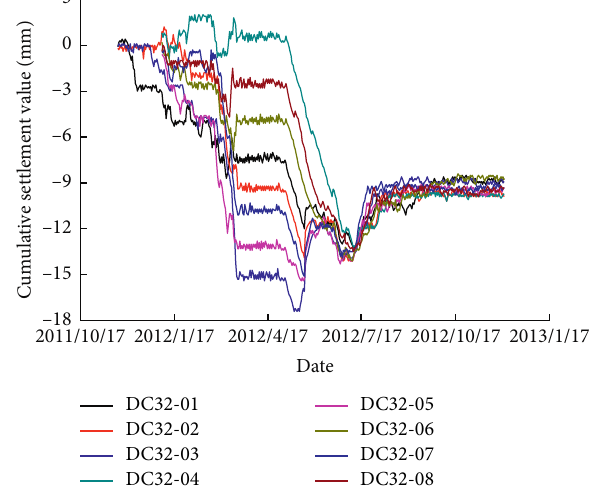
Figure 8: Settlement change curve of the construction company DC32 at Junfeng Road Table 5: Settlement changes of the surface subsidence monitoring point of Junfeng Road Station in different stages. Stages of change